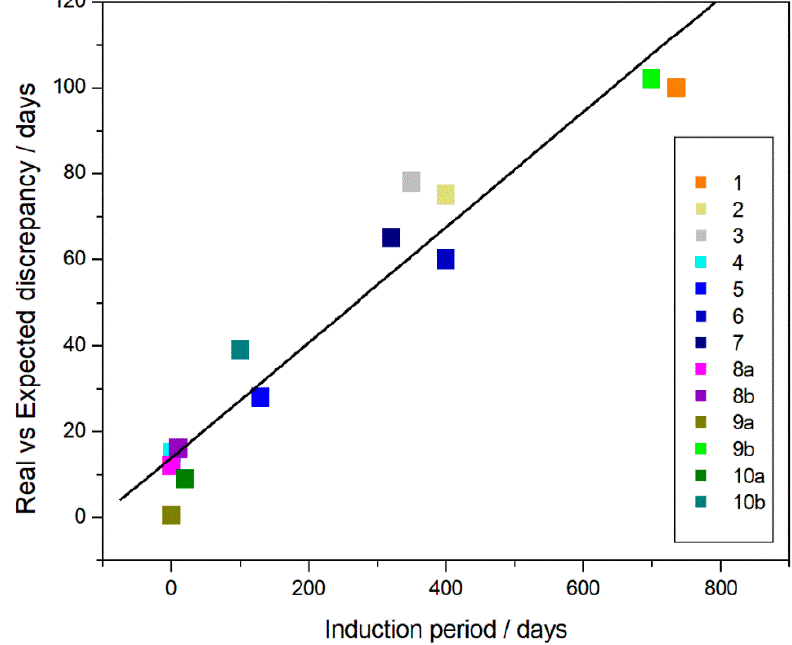
Figure 8. Relationship between the discrepancy (among the real and expected data) and the IPs observed in the long-term degradation experiments.